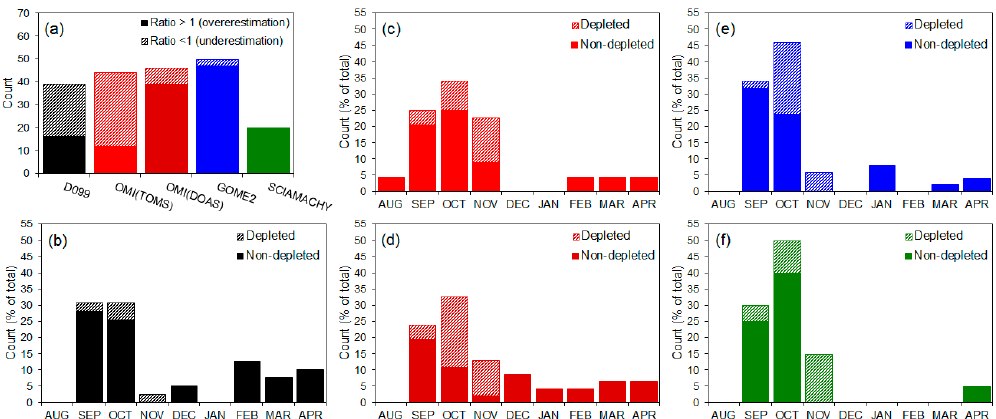
Figure 8. Extreme ratios of the different data products to the B199 TOC, ( a ) the number of extreme ratios, and the temporal distribution of the extreme ratios in relation to the B199 ozone column for ( b ) D099, ( c ) OMI(TOMS), ( d ) OMI(DOAS), ( e ) GOME2, and ( f ) SCIAMACHY under non-depleted and